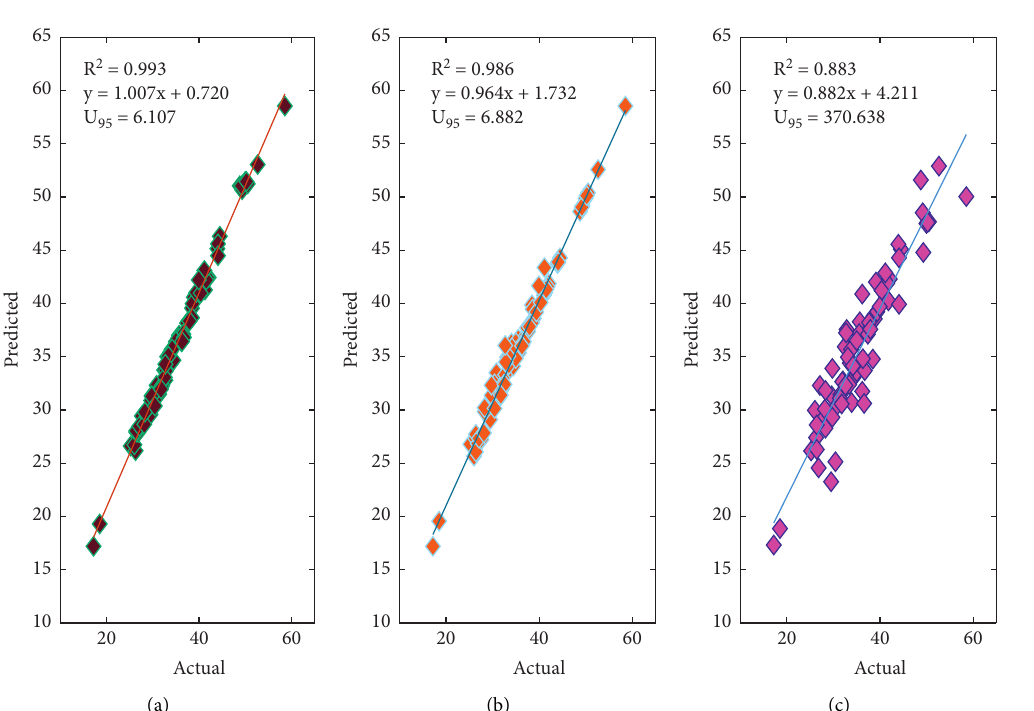
Figure 4: Comparing between actual and predictive values: correlation of determination, a, b, and c are respectively referring to SVR-PSO, SVR-GA, and ELM.